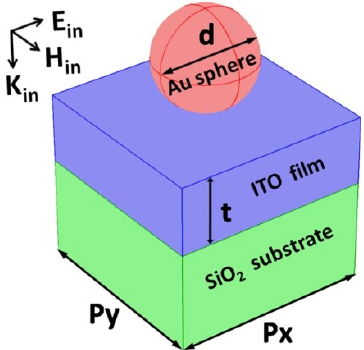
Figure 1. Schematic of a high-quality sensor based on narrowband light reflection resonances from waveguide modes.